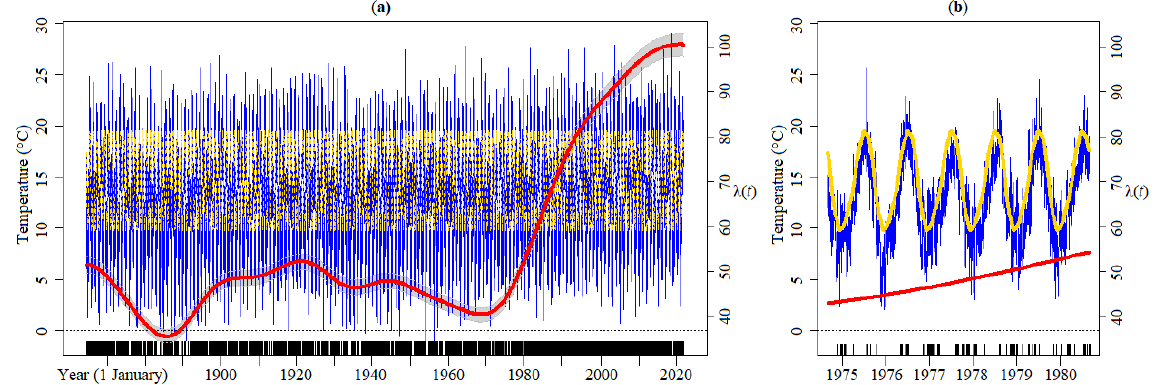
Figure 11. Time dependent occurrence rates from 1 October 1864 to 30 September 2021 of Tmin heatwave days: ( a ) daily Tmin (in blue), heatwave magnitude index threshold series, A d (in gold), number of heatwave days per year, λ ( t ) (red line), and confidence band (grey area); ( b ) detail for the period from 1975 to 1980 (the confidence band is omitted). The vertical ticks represent the time data of ≥ 3 consecutive days with Tmin above A d .